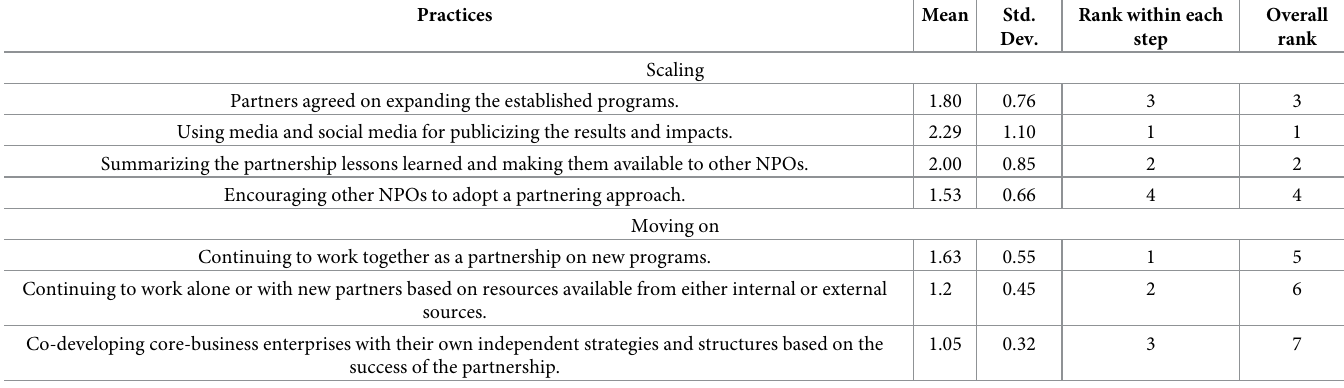
Table 5. Descriptive results of sustaining outcome practices followed by nonprofit organizations.